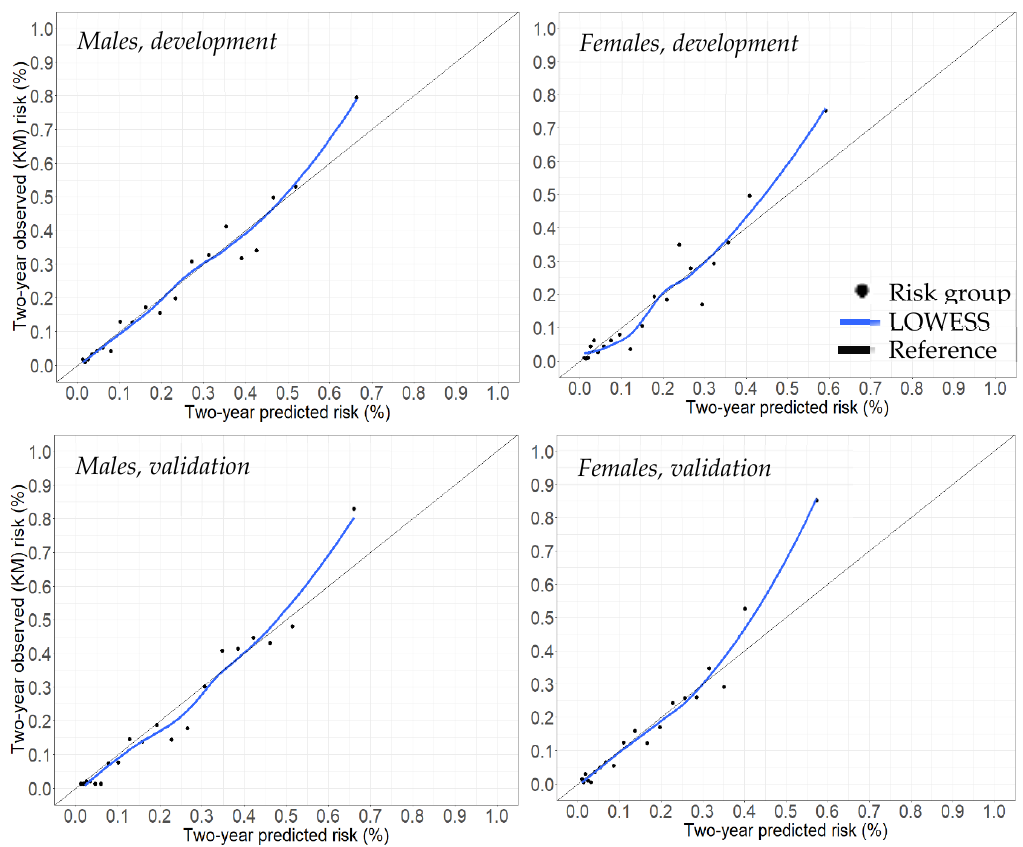
Figure 3. Calibration plots for the joint models. Abbreviations: KM = Kaplan–Meier